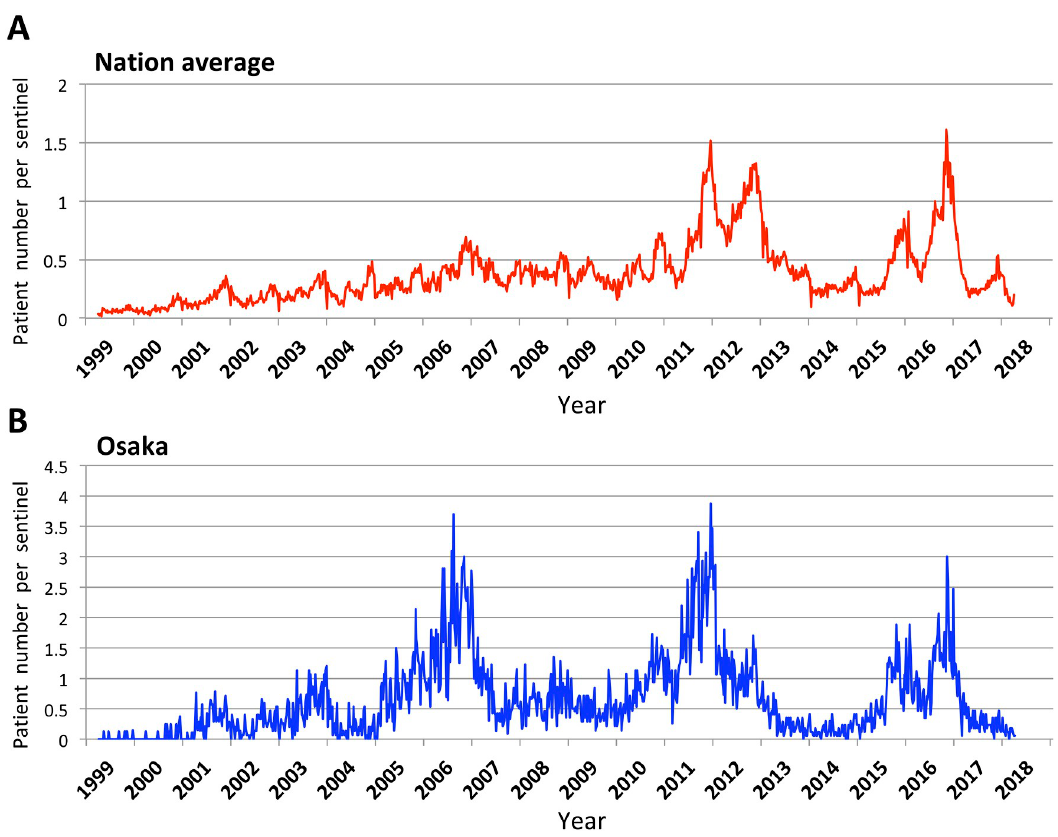
Fig 1. Surveillance of pneumonia cases associated with M . pneumoniae infection in Japan. Weekly cases of pneumonia caused by M . pneumoniae in Japan from April 1999 to present. The graphs are based on the data of the National Epidemiological Surveillance of Infectious Diseases (NESID). (A) Nation average is based on the report from about 500 sentinels. (B) The data of Osaka is based on the report from about 7 to 17 sentinels depending on the year. Also see S1 Table for detail. The latest data are available from the website of the National Institute of Infectious Diseases